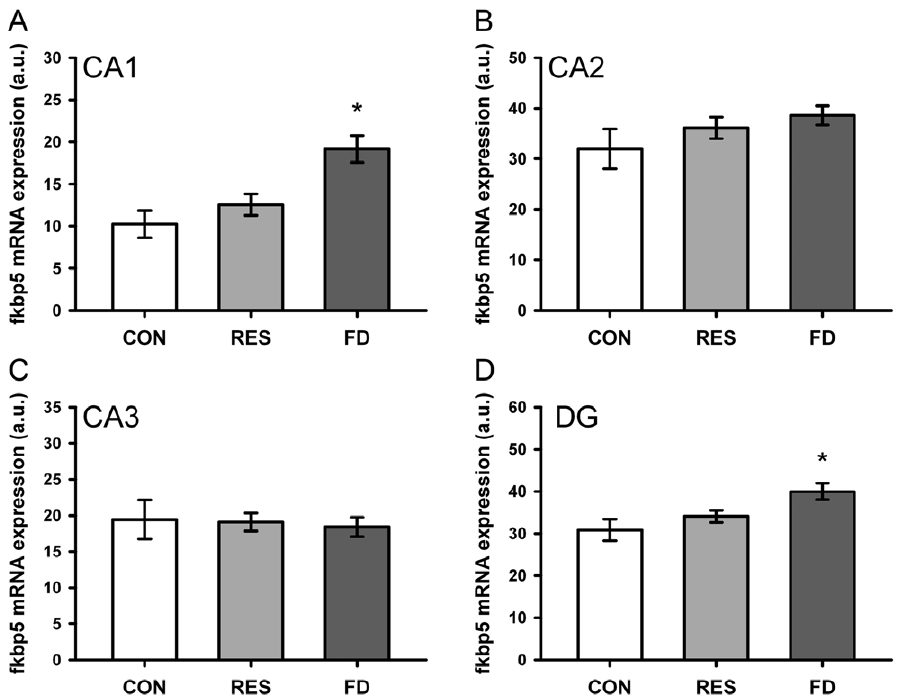
Figure 4. Regulation of fkbp5 mRNA in the dorsal hippocampus following restrained stress or food deprivation. Expression in the ( A ) CA1, ( B ) CA2, ( C ) CA3 and ( D ) DG subregions of the hippocampus. Upregulation of fkbp5 mRNA can be seen in the CA1 region as well as in the DG after 24 h of food deprivation. CON = control, RES = restrained stress, FD = food deprivation. Data are given in mean 6 SEM. * different to control p , 0.05.